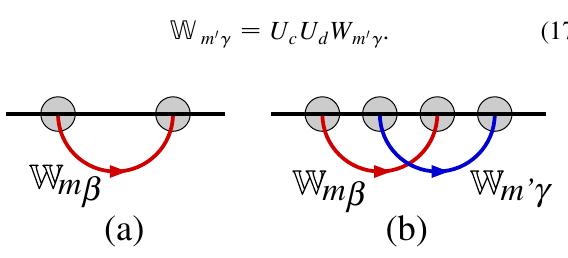
FIG. 2. The concept of annihilating particles at a gapped boundary. (a) Consider a thought experiment in which we create a pair of quasiparticle excitations m , (cid:3) m in the bulk and then bring them near two points a , b at the edge. We denote the resulting excited state by j (cid:2) ex i . (b) We say that m , (cid:3) m can be annihilated at the boundary if there exist operators U a , U b acting in the vicinity of a , b , such that U a U b j (cid:2) ex i ¼ j (cid:2) i , where j (cid:2) i is the ground state. Otherwise, we say the particles cannot be annihilated.